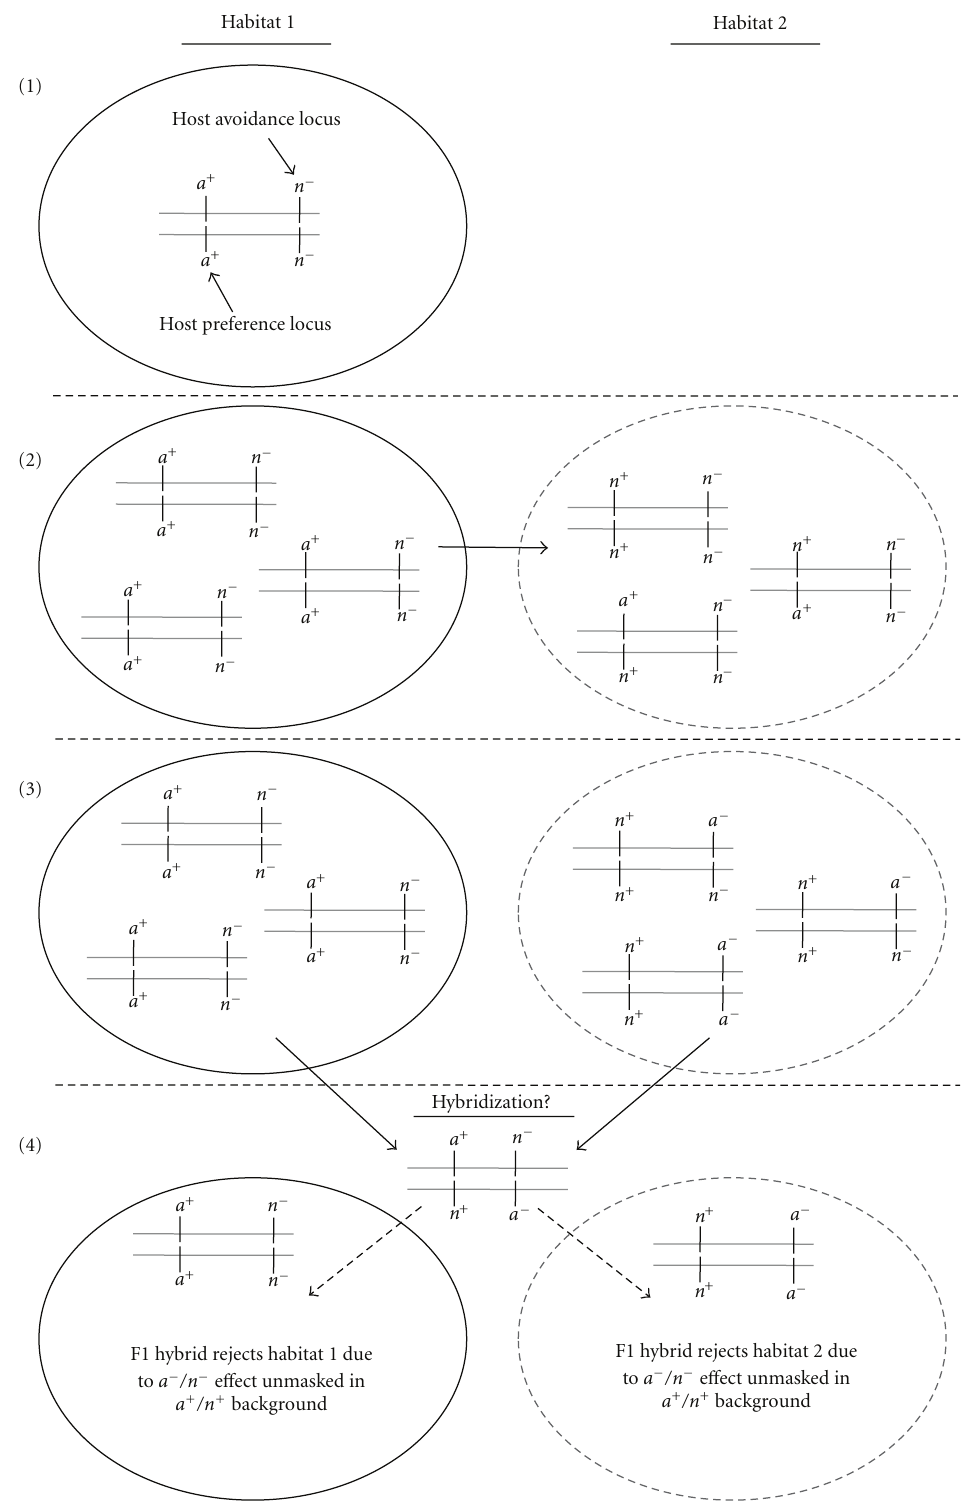
Figure 2: Illustration of model 2 based on epistasis between habitat preference and avoidance loci. Numbered steps of model (1–4) are separated by dashed lines and ordered vertically. Individuals are represented by chromosome pairs as grey bars; preference locus (on left) and avoidance locus (on right) are marked by two pairs of vertical black tick marks on grey chromosomes. Alleles at preference locus are labeled as follows: a + : preference for ancestral habitat; n + : preference for novel habitat. Alleles at avoidance locus are labeled as follows: n − : avoidance for novel habitat; a − : avoidance for ancestral habitat. Arrow depicts shift from ancestral habitat 1 to novel habitat